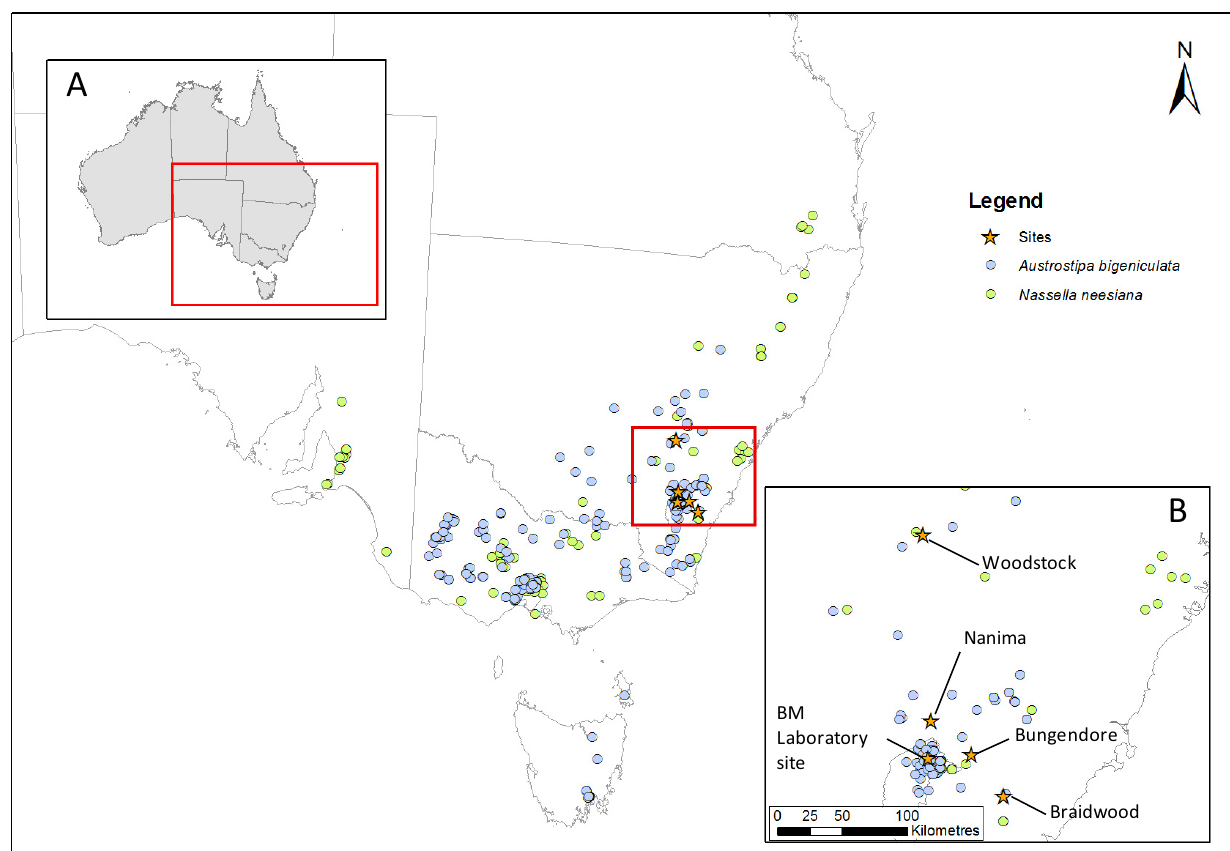
Figure 1. Schematic showing the study region (inset A) and herbarium specimen collection records for Austrostipa bigeniculata and Nassella neesiana across south-eastern Australia. The specific locations of the study sites along with the Black Mountain (BM) Laboratory site where glasshouse and field studies were performed are shown in inset B.